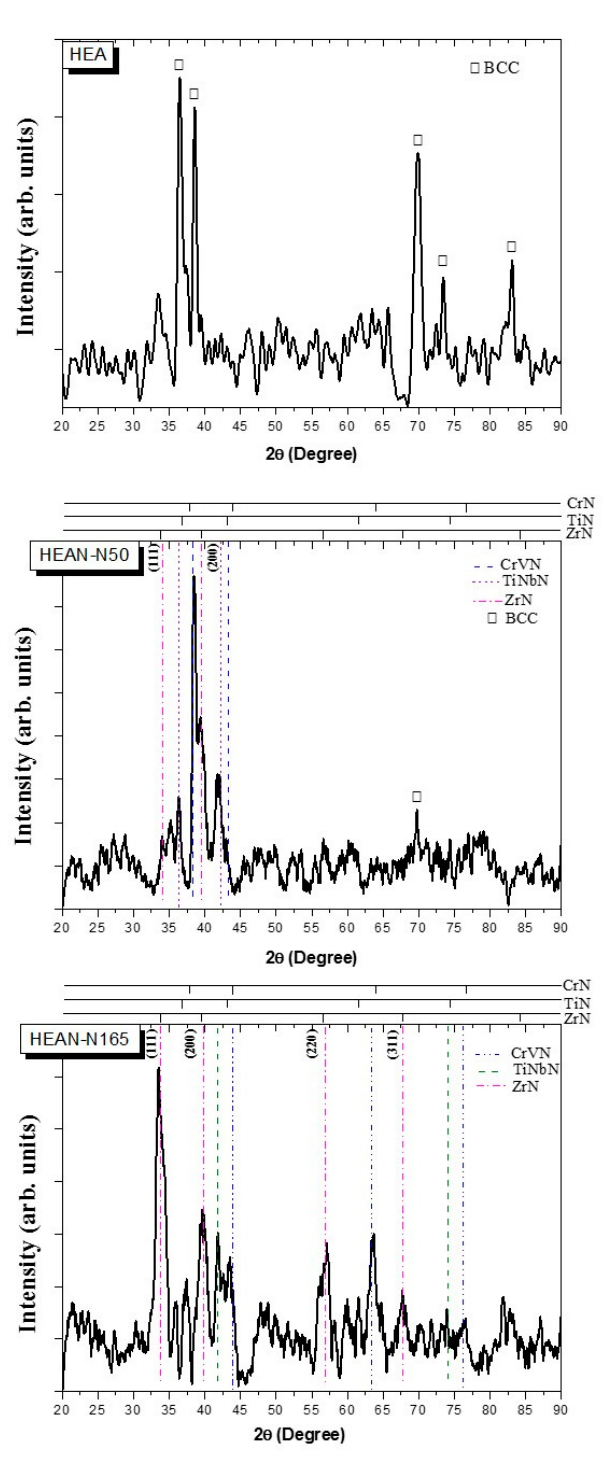
Figure 2. Glancing angle X ‐ ray diffraction pattern of the deposited CrVTiNbZr(N) coatings with different nitrogen flow rates (HEA, HEAN ‐ N50 and HEAN ‐ N165).